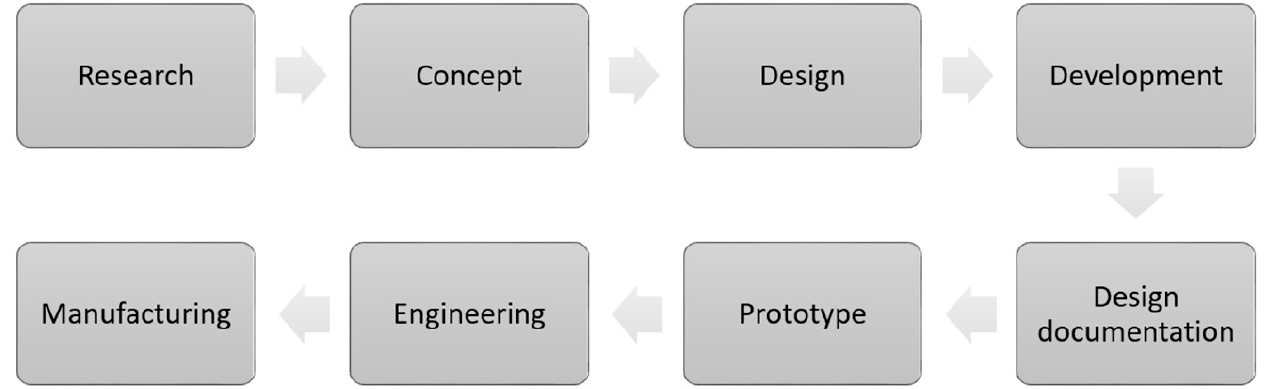
Figure 7. Biocomposite product development flow. Adapted with permission from Ref. [105]. Copyright 2021 MDPI.